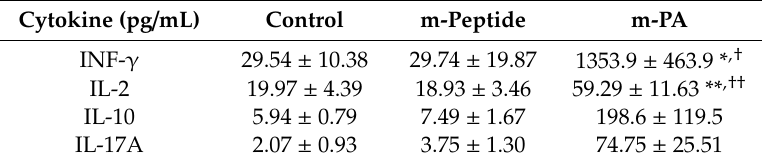
Cytokine quantification. Levels of splenocyte-secreted cytokines upon stimulation with each antigen were determined using bead-based multiplex assays. All data are presented as mean ± SEM ( n = 4). Significance is indicated as follows: * p < 0.05, ** p < 0.01 compared to control group, † p < 0.05, †† p < 0.01 compared to the m-peptide